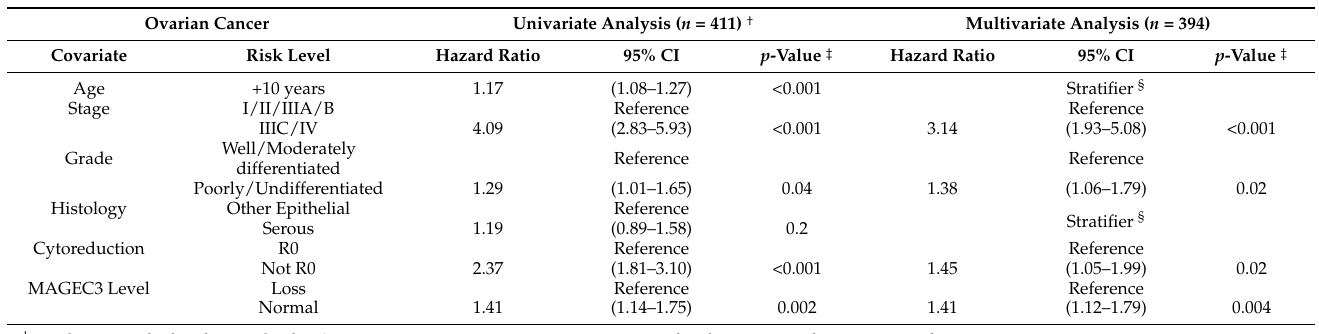
Table 2. Discovery cohort survival analysis. Univariate and multivariate survival analyses of epithelial ovarian cancer (global proportional hazards test p =